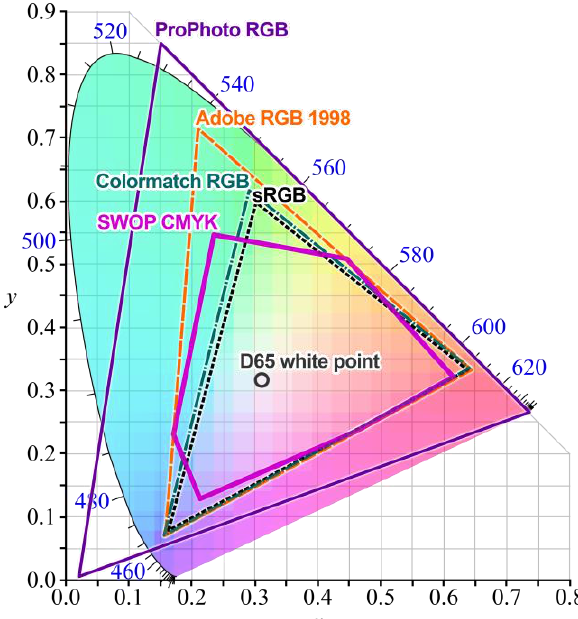
Figure 1. Colour spaces projected onto the 1931 CIE chromacity diagram (Wikimedia Commons contributors, 2014)